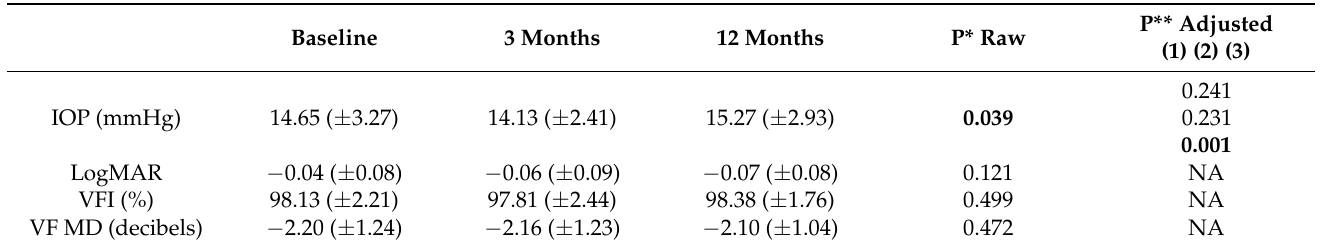
Table 2. Variables recorded at baseline and at 3 and 12 months of follow up in patients with obstructive sleep apnea undergoing continuous positive airway pressure treatment.